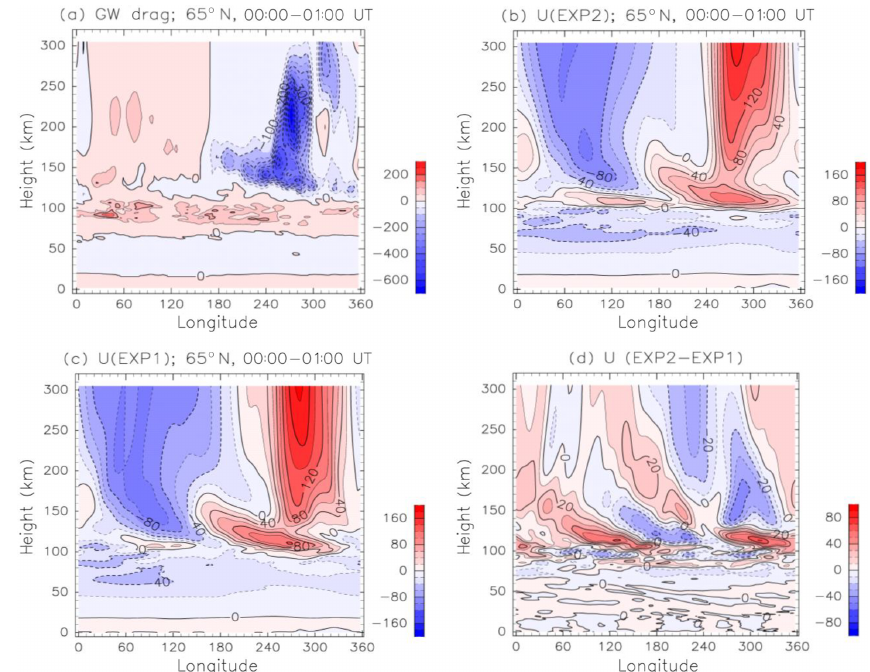
Figure 10. (a) Height–longitude section of the zonal GW drag at 65 ◦ N in June (EXP2). Data are averaged between 00:00 and 01:00UT. Units are meters per second per day. Contour intervals are 50ms − 1 d − 1 . (b) As in (a) except for zonal-wind component obtained by EXP2. Units are meters per second. (c) As in (b) except for EXP1. (d) Difference of the zonal wind at 65 ◦ N between EXP1 and EXP2 (EXP2–EXP1). Units are meters per second. Contour intervals are 10ms − 1